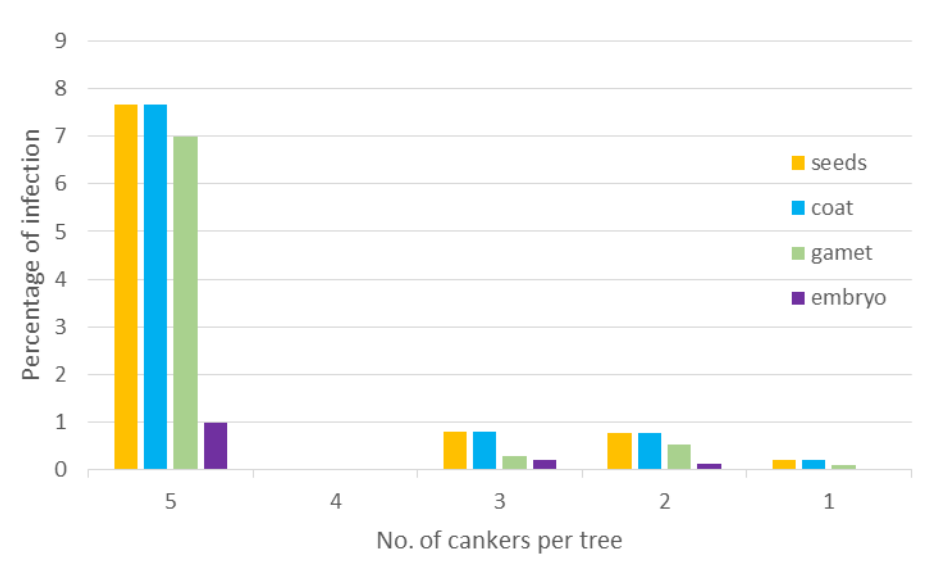
Figure 1. Percentage of plantation-collected Pinus radiata (P. radiata) seeds with the presence of F. circinatum and their location on coat, gametophyte and embryo in relation to the tree disease severity (measured by the number of cankers) where seeds were